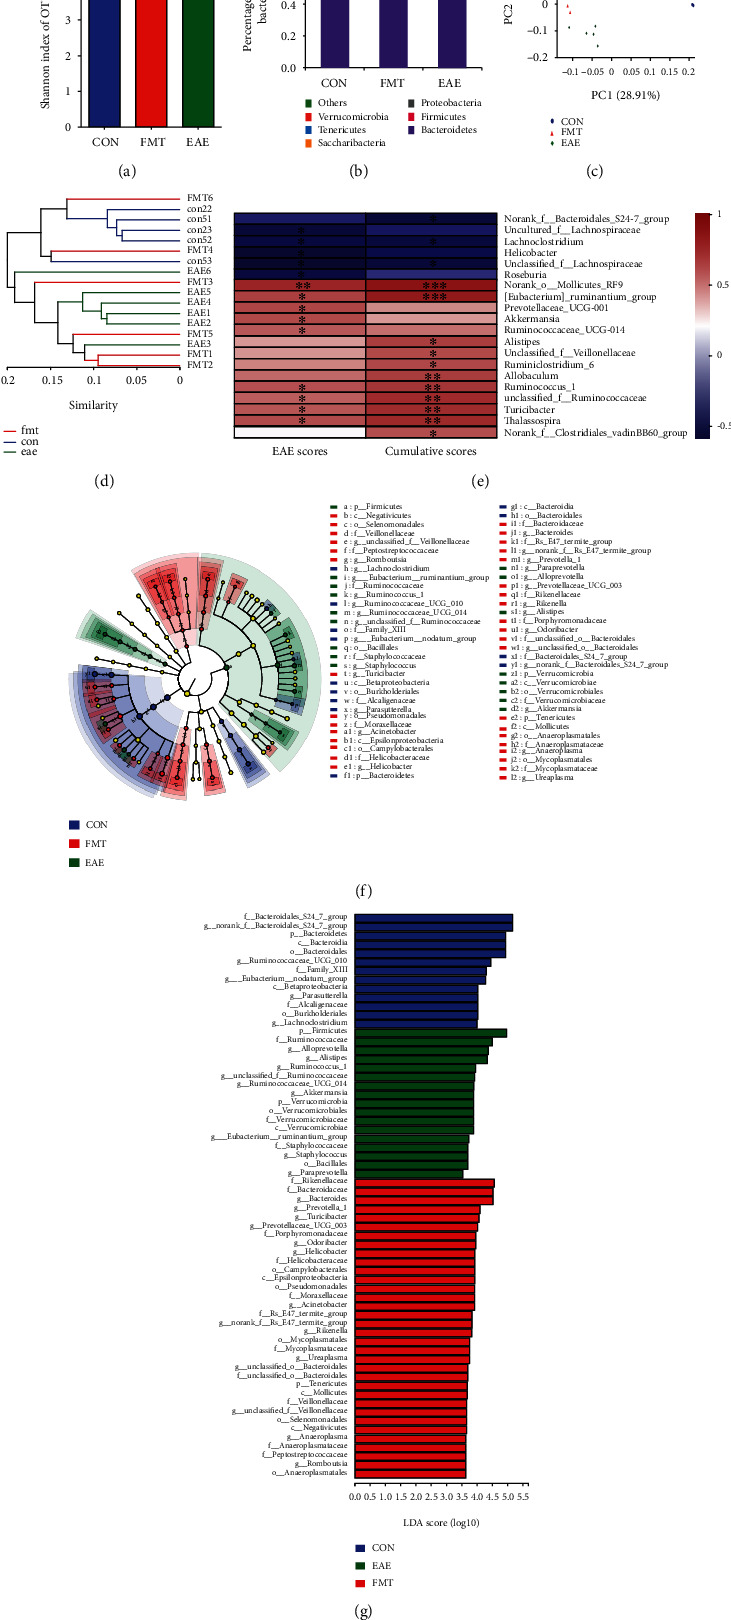
FMT modulates GM in EAE. (a) Chart of the Shannon index values for evaluation of GM α-diversity. The Shannon index for GM was significantly increased in EAE mice (n = 6) compared to normal controls (CON, n = 5); an in-between value was found in FMT-treated immunized mice (FMT; n = 6) without statistical significance. (b) Chart of relative abundance of gut bacterial taxa (phylum level) performed with the Mann–Whitney U test, corrected by FDR between the two groups. The figure was created by used unfiltered OUT table. (c) PCoA plot (PC1/PC2) of unweighted UniFrac distances illustrating clustering separation between samples from different mouse groups. (d) Hierarchical clustering tree on OTU level (weighted UniFrac). (e) The correlation heatmap chart performed with a Spearman's correlation of bacterial abundance with EAE scores and cumulative scores. The R value is shown in different colors in the figure. The legend on the right is the color interval of different R values (∗0.01 < p < 0.05 and ∗∗0.001 < p < 0.01). (f) LEfSe cladogram showing differentially abundant gut bacterial taxa. The diameter of each dot is proportional to its effect size. Each ring (from inside to outside) represents a taxonomic level from kingdom to genus, the cladogram was made on filtered data, and only taxa with greater than 0.1% relative abundance. (g) LDA scores of abundant gut bacterial taxa (LDA score threshold >2.0). k: kingdom; p: phylum; c: class; o: order; f: family; g: genus.